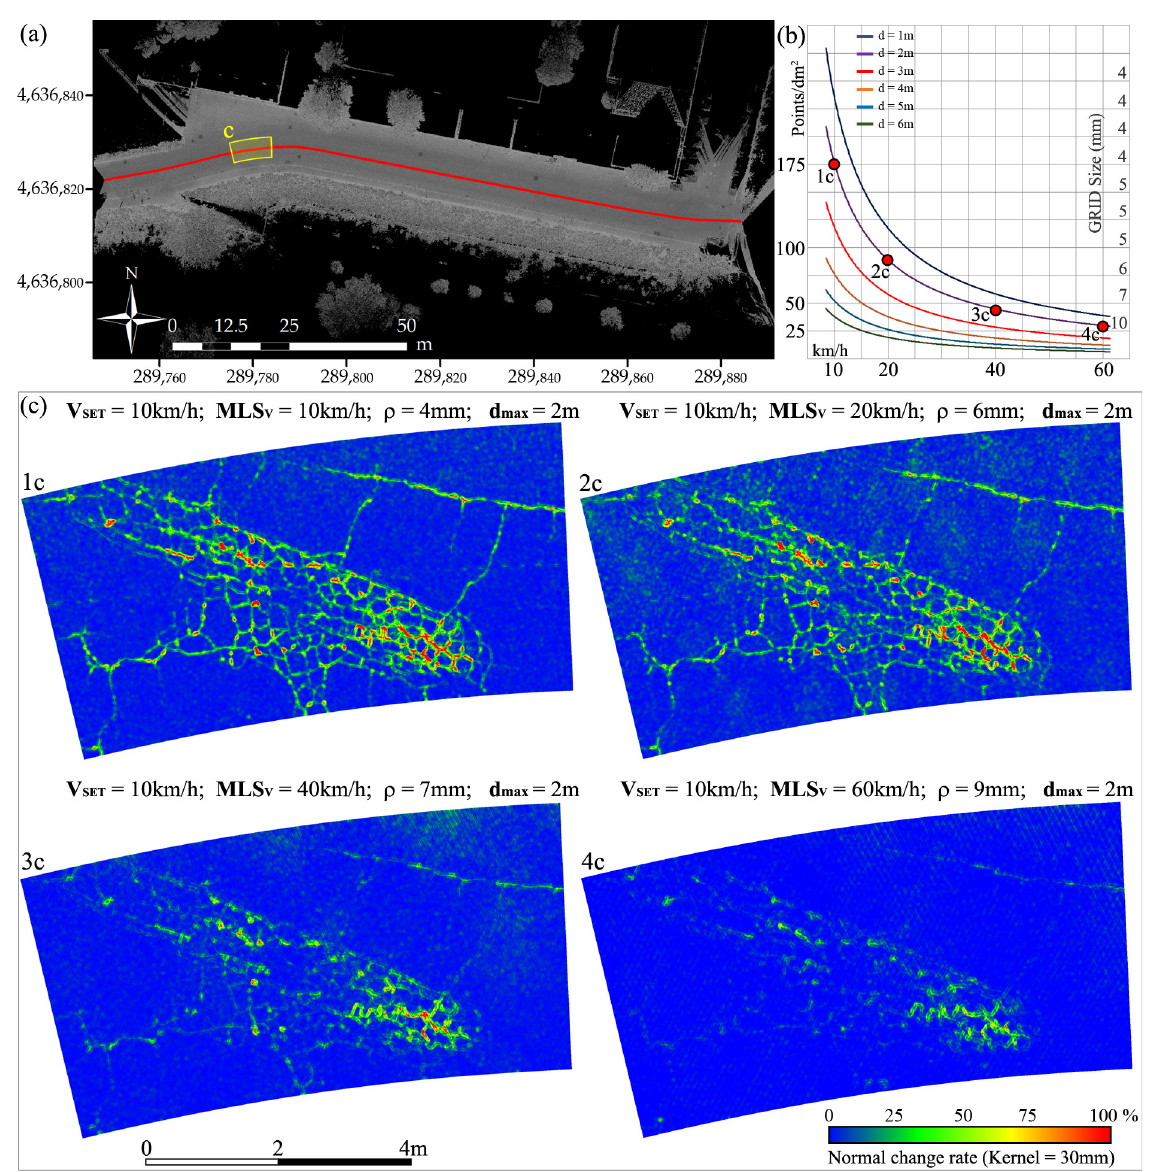
Figure 14. Identification of the distresses on the DEMc. ( a ) Top view of the point cloud: the red polyline represents the trajectory of the MLS, the yellow box the portion of road analyzed; ( b ) Correlation between density, MLS velocity (MLS V ) and resolution of the corresponding DEMc ( ρ ); ( c ) Excerpt of the DEMc at different resolutions, compatible with the identification of cracking (panels 1c , 2c ), not compatible with cracking of medium/low severity levels (panels 3c , 4c ).